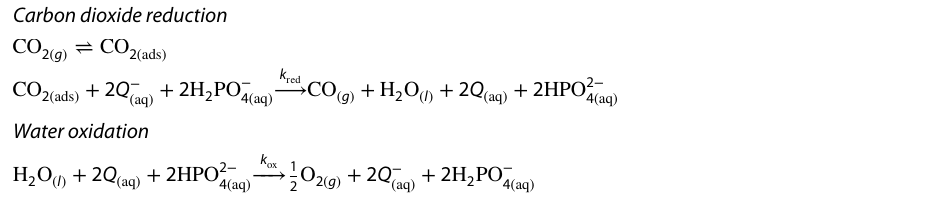
Table 1 Kinetic model for the two half reactions in the two surfactant